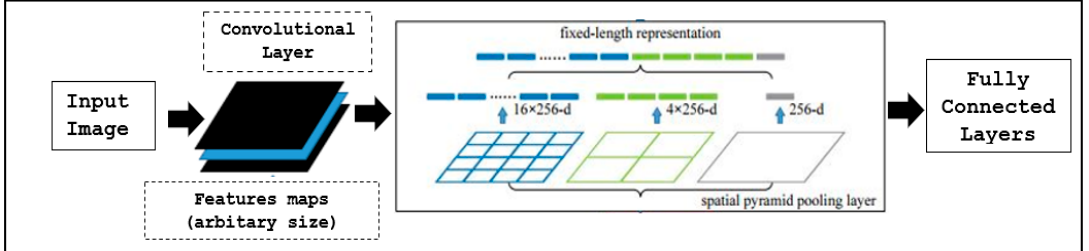
Figure 2. SPP network layers.